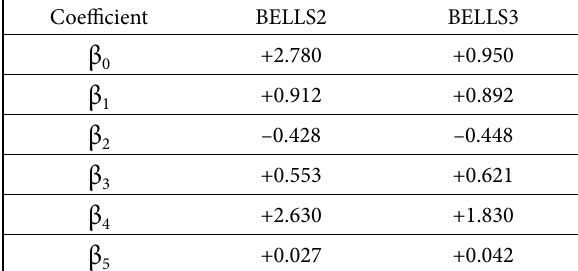
Table 1 (AASHTO T317:2009). Table 1. Coefficients of BELLS2 and BELLS3 equations